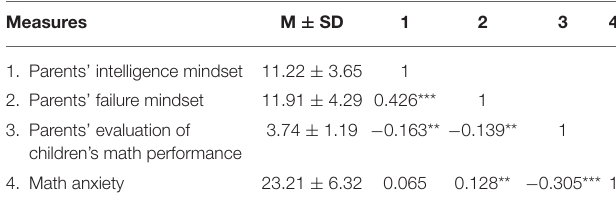
TABLE 2 | Descriptive statistics and